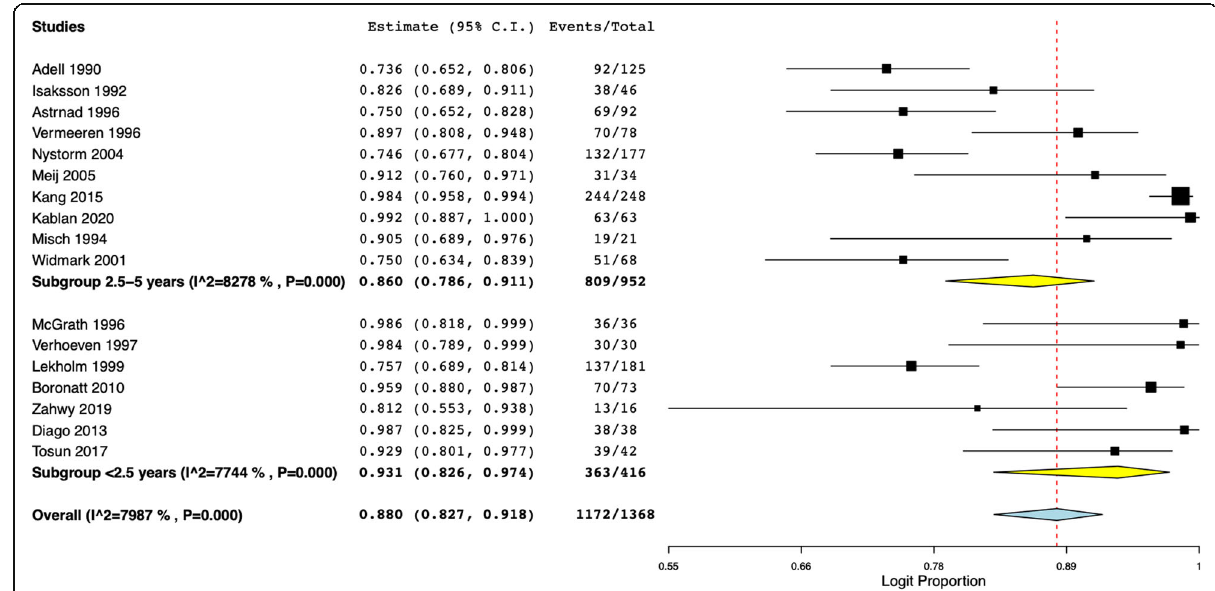
Fig. 2 Meta-analysis of implant survival with sub-group analysis based on follow-up